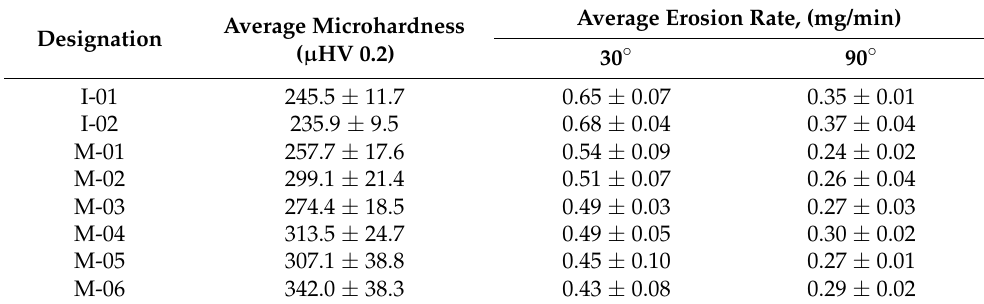
Table 5. The average Vickers microhardness and erosion rates of Inconel 625/TiC laser cladded coatings (coatings designation according to Table